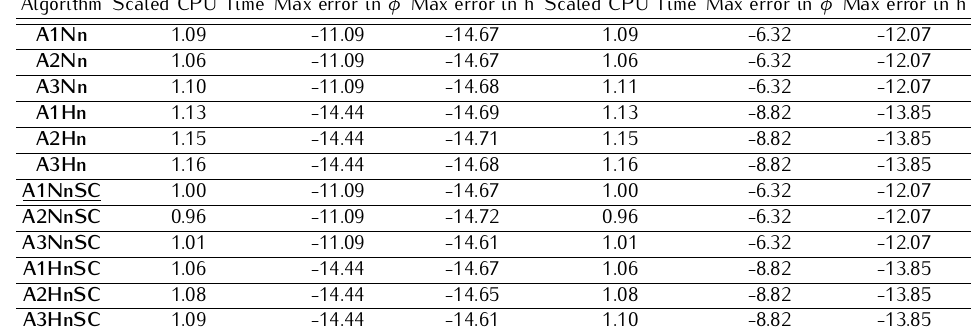
Table 1. Scaled CPU times and accuracy characteristics for the